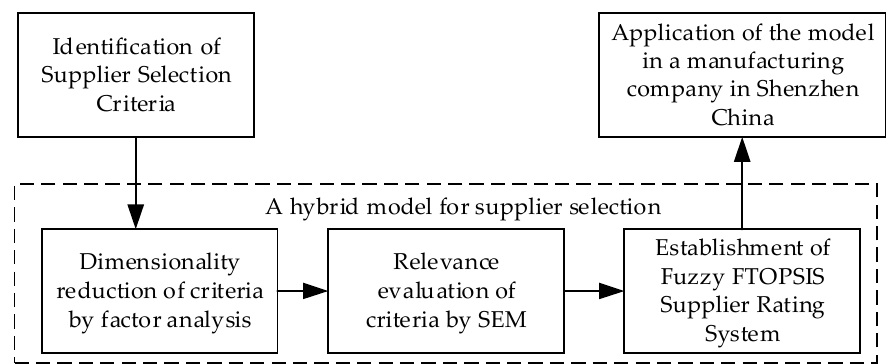
Figure 1. The methodology of the study.